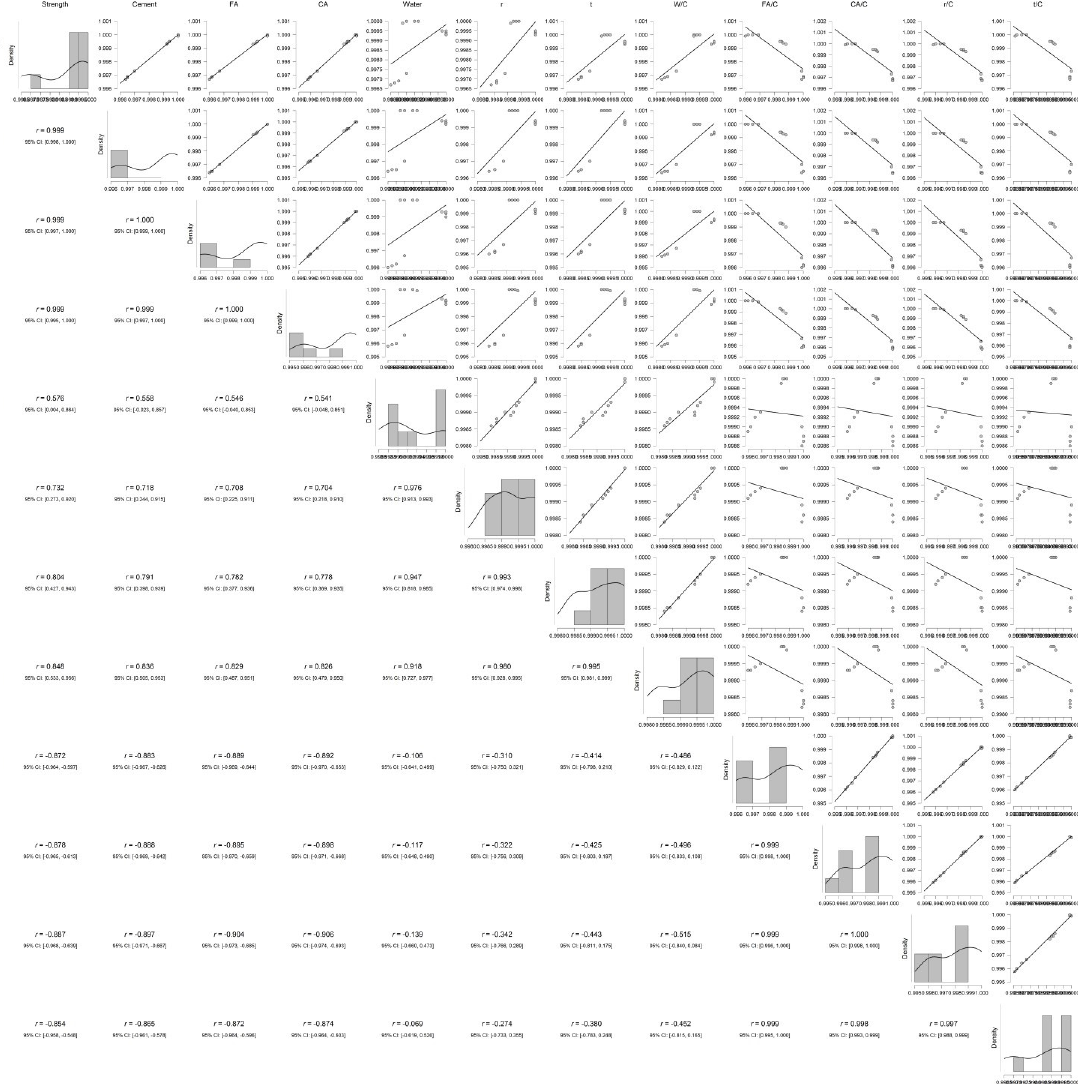
Figure 3: Scatter Plot of Parameters